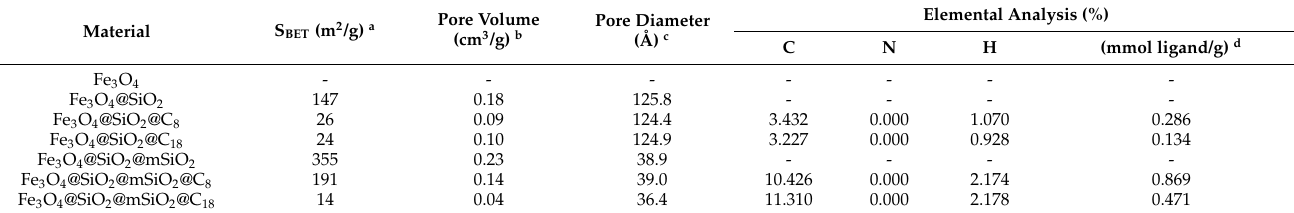
Table 1. Textural properties of the six magnetic materials